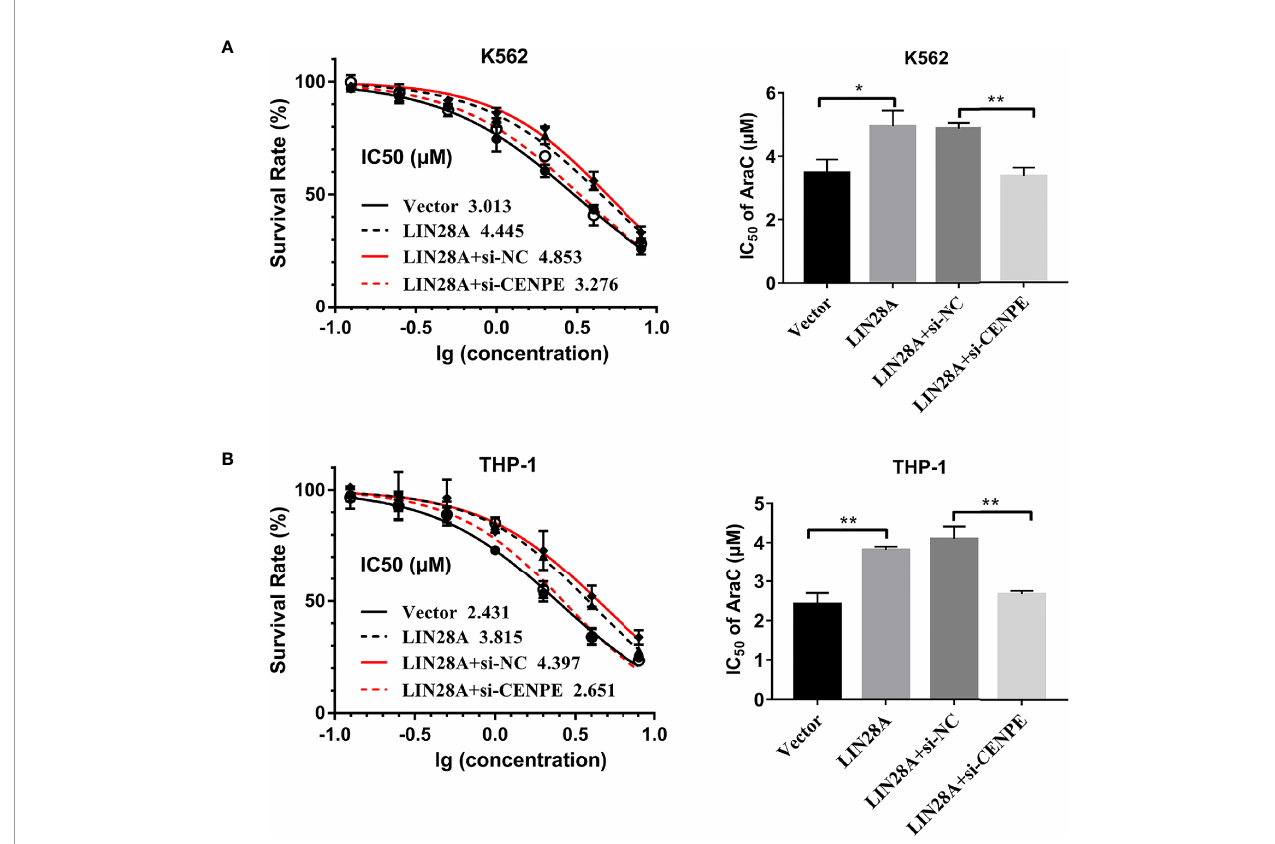
FIGURE 10 | LIN28A/CENPE interaction effected Ara-C resistance in K562 and THP-1 cells. (A, B) LIN28A overexpressed and CENPE interfered LIN28A overexpressed K562 and THP-1 cells were treated with ascending concentrations of Ara-C (0.125 µM, 0.25 µM, 0.5 µM, 1 µM, 2 µM, 4 µM, and 8 µM). After 48 h, IC50 values were measured and analyzed by the CCK-8 method. The experiment was independently repeated three times and statistical differences were analyzed. * p < 0.05. ** p <